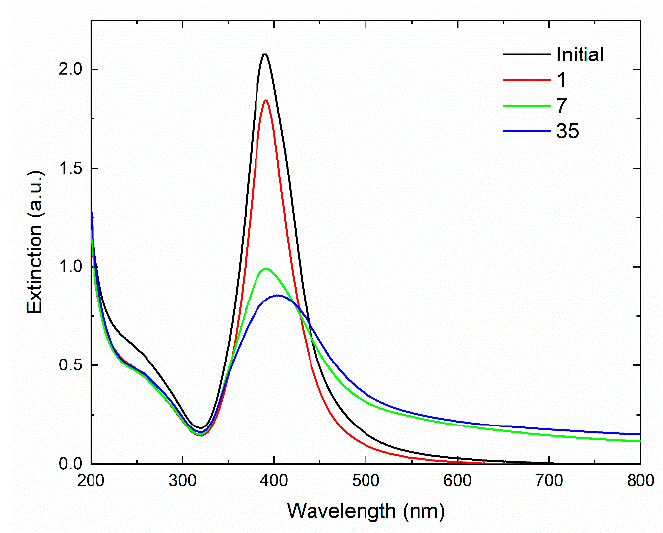
Figure 3. Optical extinction spectrum of silver hydrosol after photochemical reduction of 1.5 × 10 − 4 mol L − 1 Ag + ions in the presence of 2 × 10 − 4 mol L − 1 C 2 O 42 − , followed by storage in air for 1, 7 and 35 days, respectively. In the course of the photochemical reduction of the Ag + ions, the IBT absorption grad- limiting value corresponding to the complete reduction of the ions and the formation of the colloidal metal (Figure 4a). The lower the initial ions concentration, the shorter the time of their complete reduction.